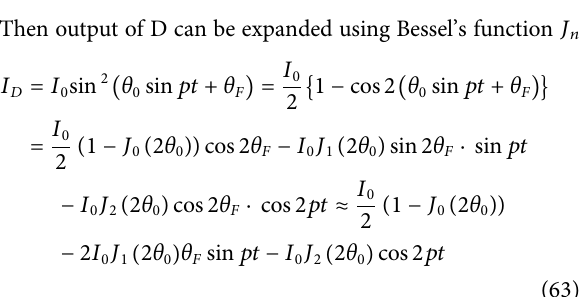
Frontiers in Physics |